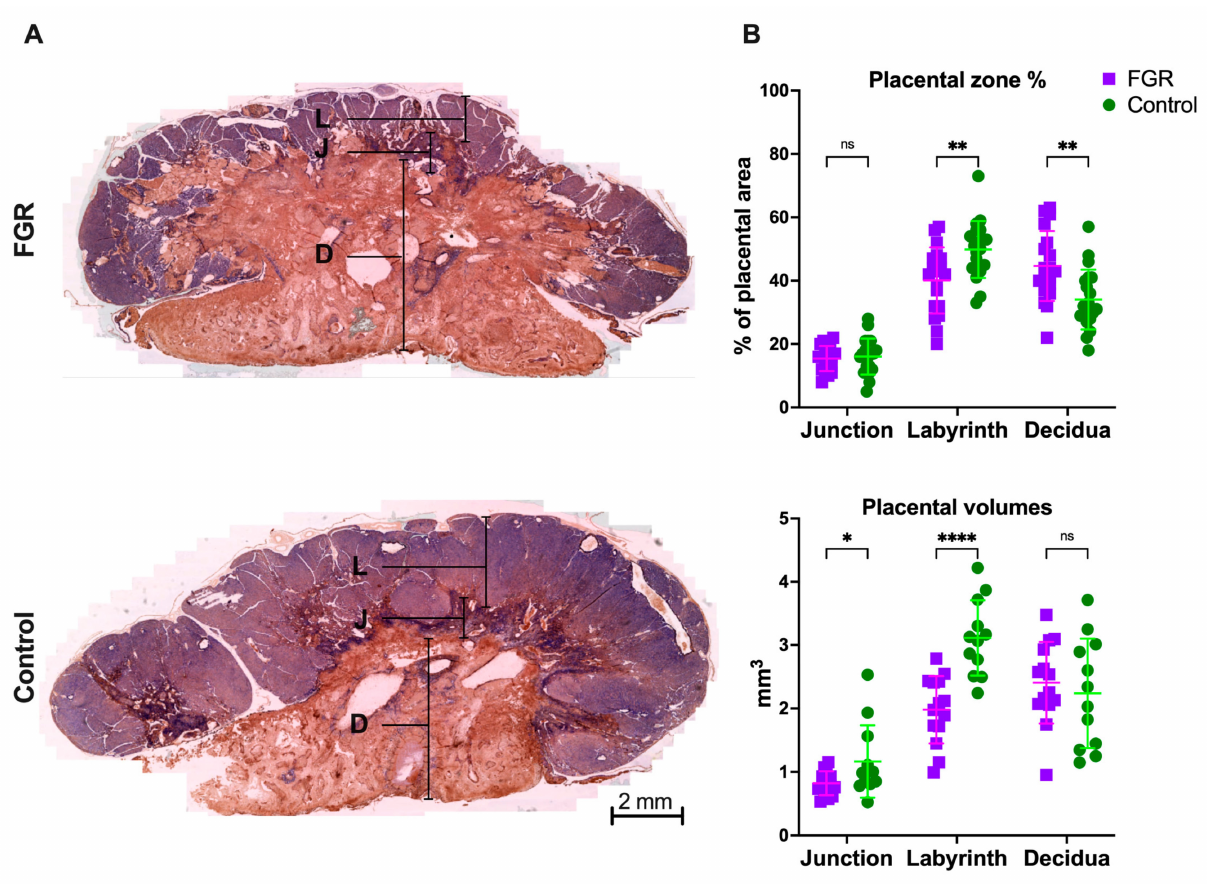
Figure 1. Placental histology: ( A ) placentas with cytokeratin/lectin double staining; ( B ) placental zone proportions from 19 FGR and 20 control placentas from 13 litters. Data were analyzed using a linear mixed-effects model and displayed as median ± IQR with significance as ns p > 0.05; * 0.05 ≥ p > 0.01; ** 0.01 ≥ p > 0.001.; **** p < 0.0001. D: decidua; FGR: fetal growth restriction; J: junction zone; L: labyrinth